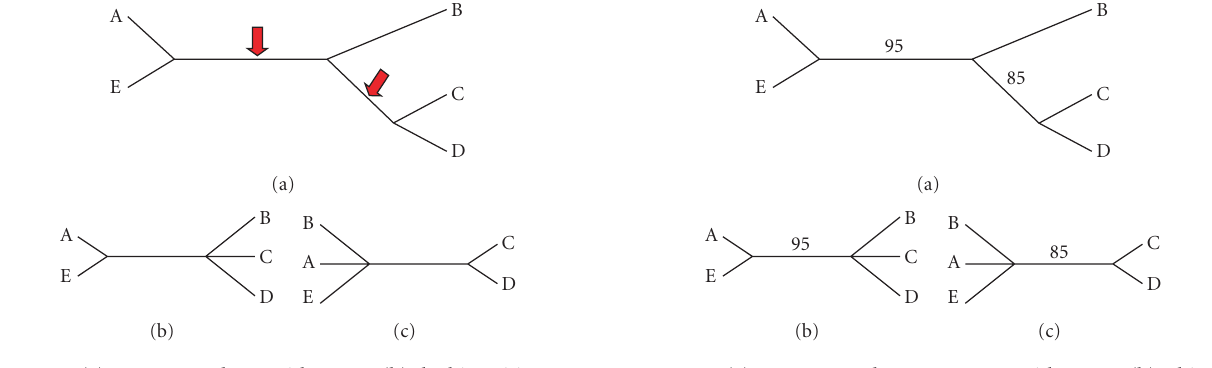
Figure 3: (a) Bootstrapped consensus tree with 5 taxa, (b) a bipar- tition with a 95% bootstrapped confidence value, (c) a bipartition with an 85% bootstrapped confidence